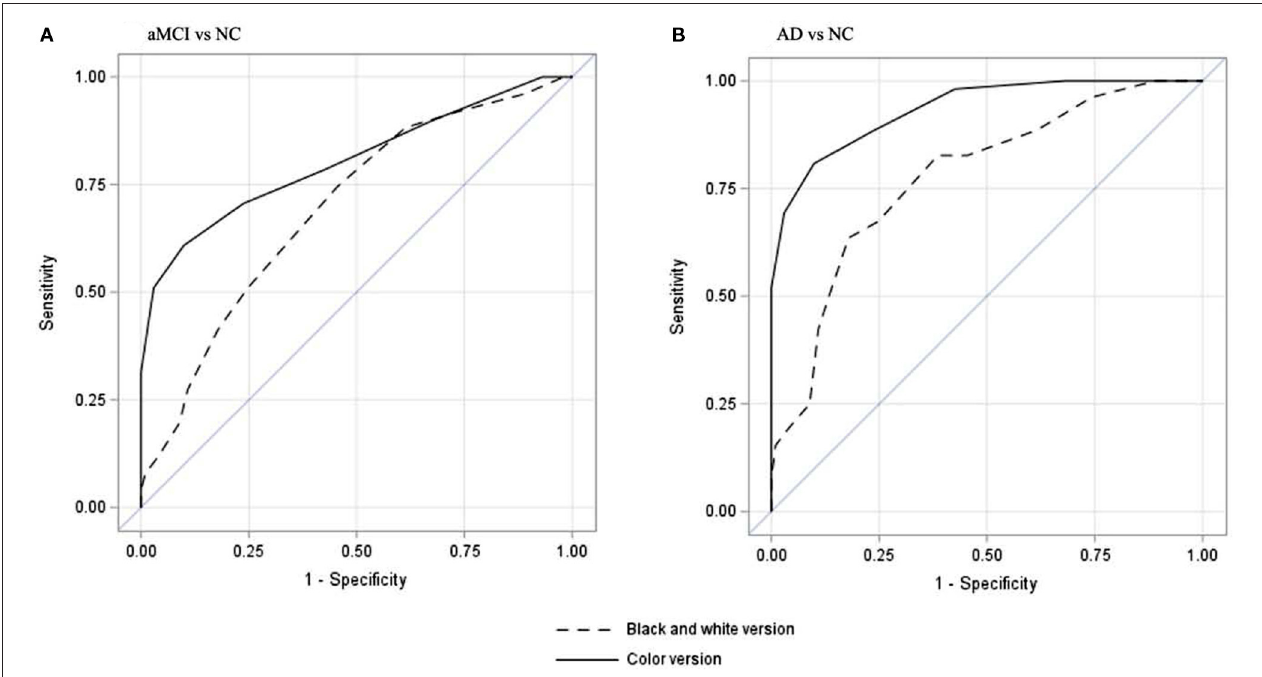
FIGURE 1 | Receiver operating characteristic curves of spontaneous naming score to differentiate aMCI from NC (A) and to differentiate mild AD from NC (B) . (A) showed that CP-BNT had a better AUC (80.3%, 95%CI: 72.4–88.4%) than that of BW-BNT (AUC = 69.4%, 95%CI: 60.7–78.1%) to differentiate aMCI from NC. (B) showed that CP-BNT had a better AUC (93.5%, 95%CI: 89.6–97.2%) than that of BW-BNT (AUC = 77.6% (95%CI: 69.9–85.3%) to differentiate AD from NC.